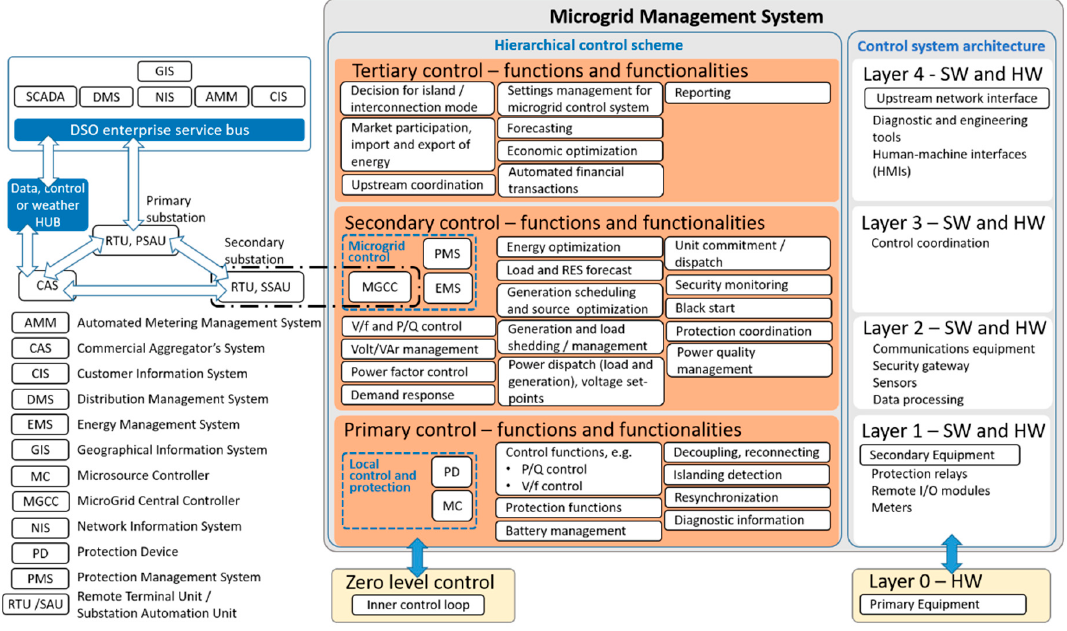
Figure 4. The functions of a microgrid management system.